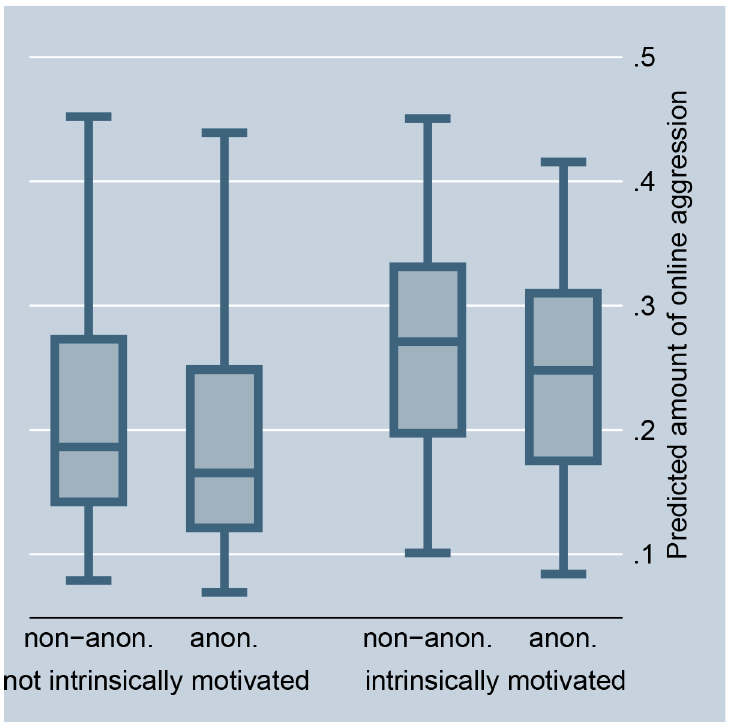
Fig 5. Online aggression dependent on intrinsic motivation and anonymity (fixed-effects). Predictions of Table 1, Model 2.